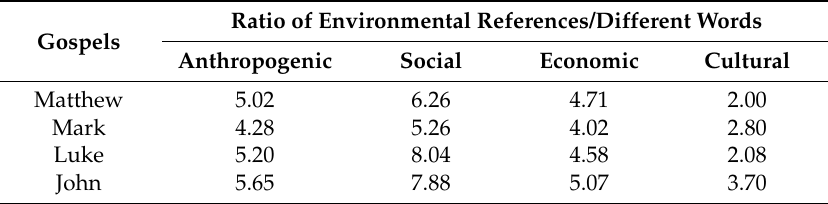
Table 10. Ratio of environmental references/unique words of the anthropogenic environment.